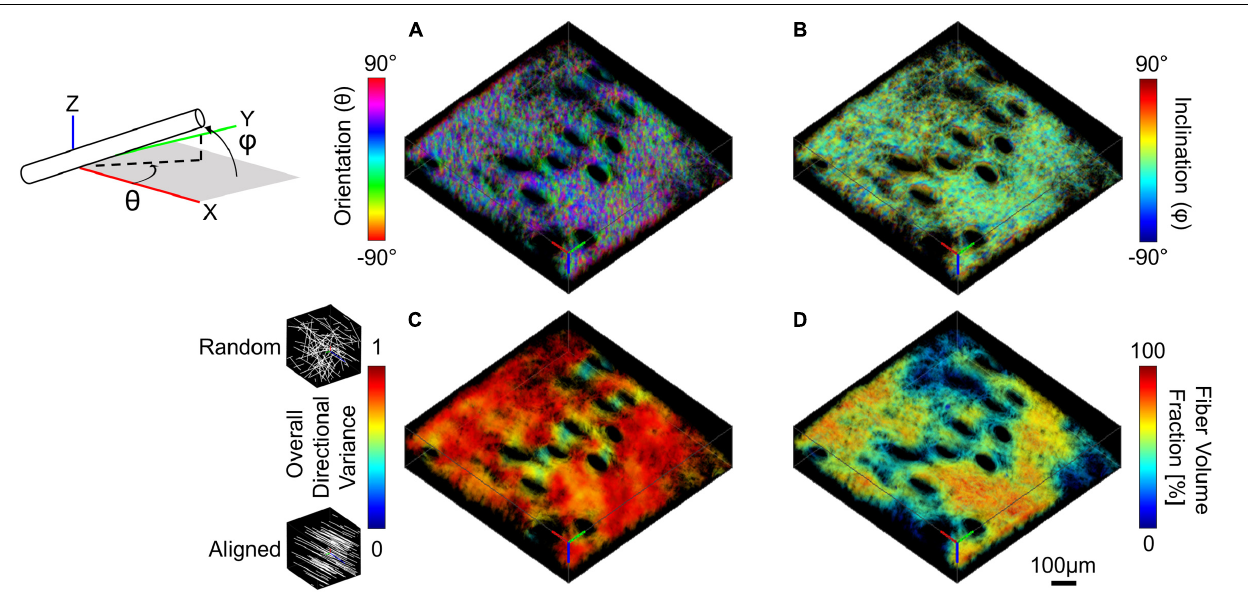
FIGURE 3 | SHG image volumes were used to compute a pixel-wise map of 3D micro-scale orientation (A) and inclination (B) . The two 3D orientation and inclination maps and collagen-positive mask were then convolved with a range of cubic averaging kernels varying in size to determine how regional measurements of directional variance (C) and fiber volume fraction (D) change as a function of the length scale over which they are measured (convolution with 40 µ m 3 kernel shown here, scale bar represents 100 µ m).